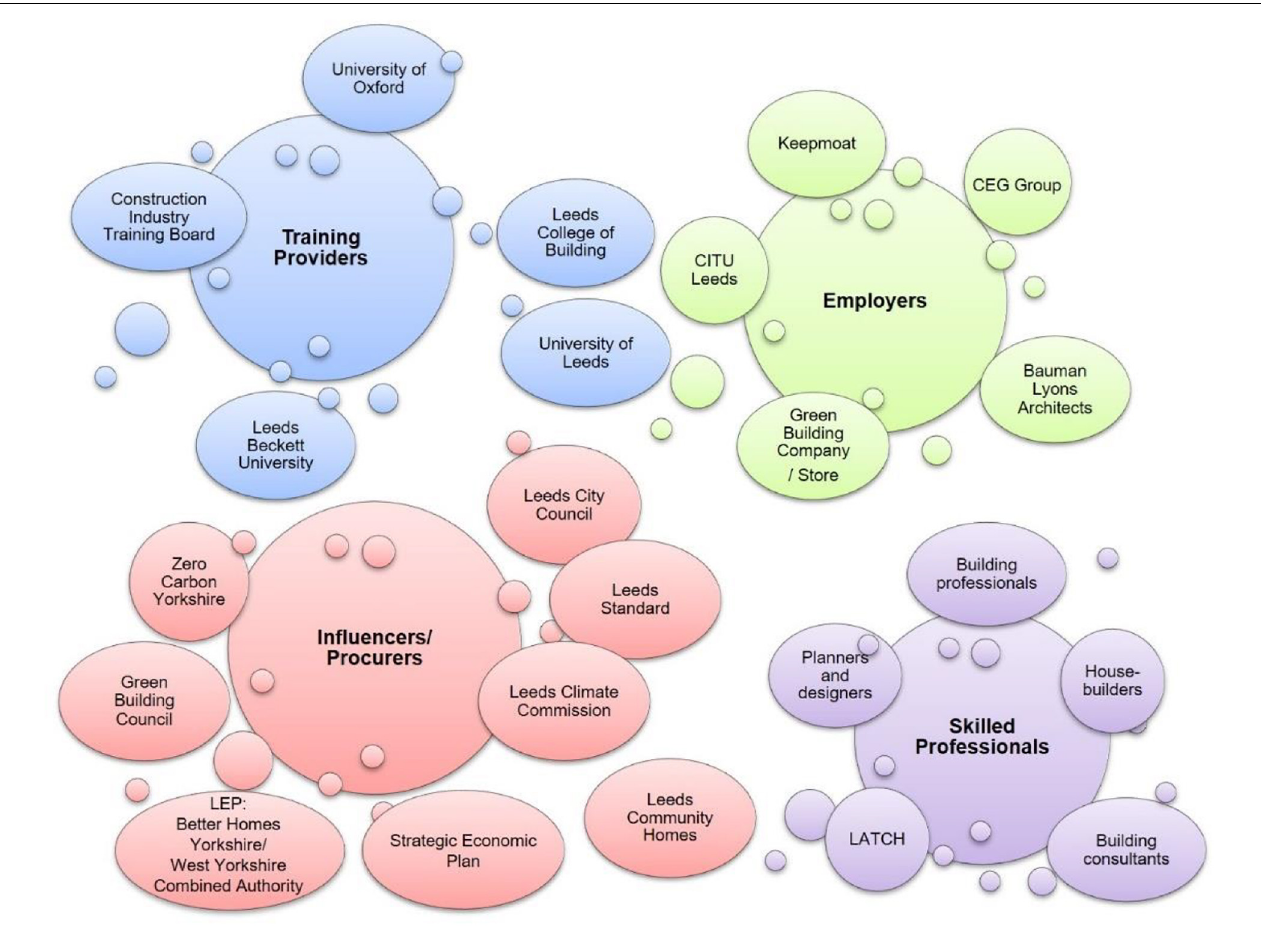
FIGURE 1 | System of networked roles engaged in the workshop.